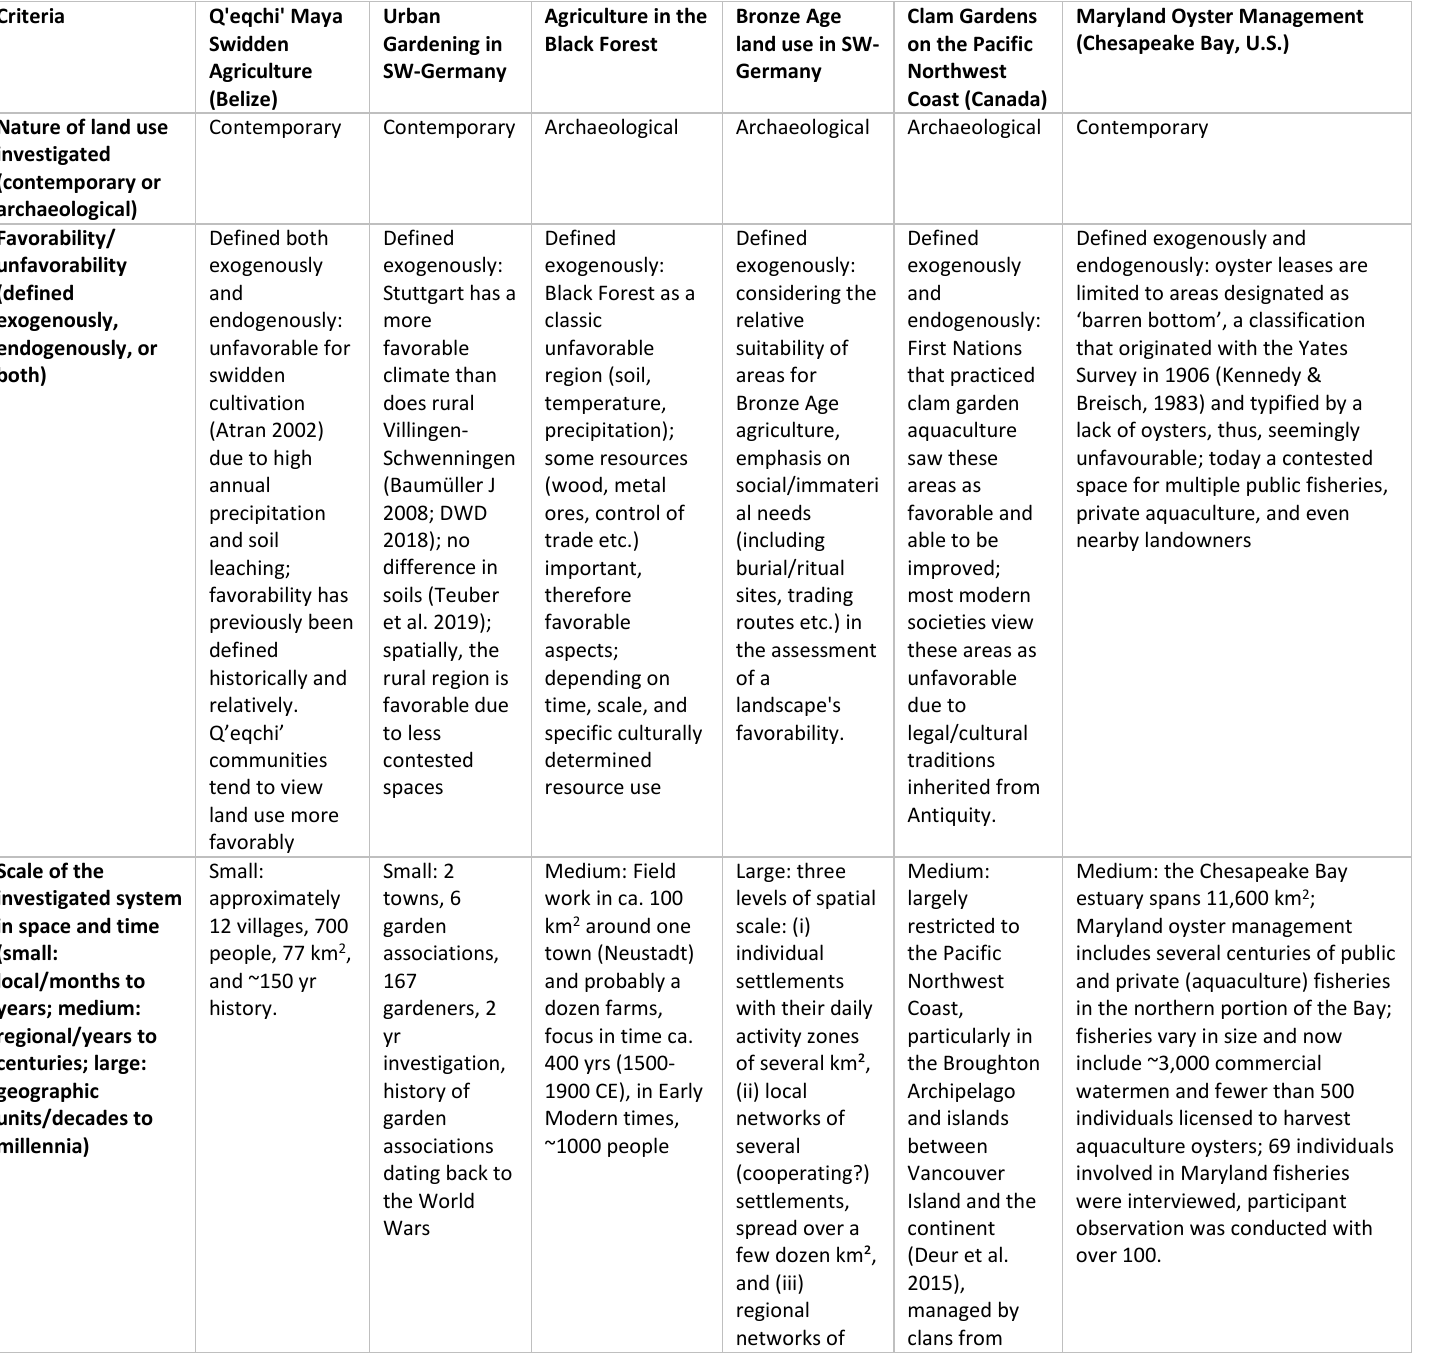
Table A1.1 Summary of Case Study Data Evaluated Under the Rubric of Complex Adaptive Systems Criteria